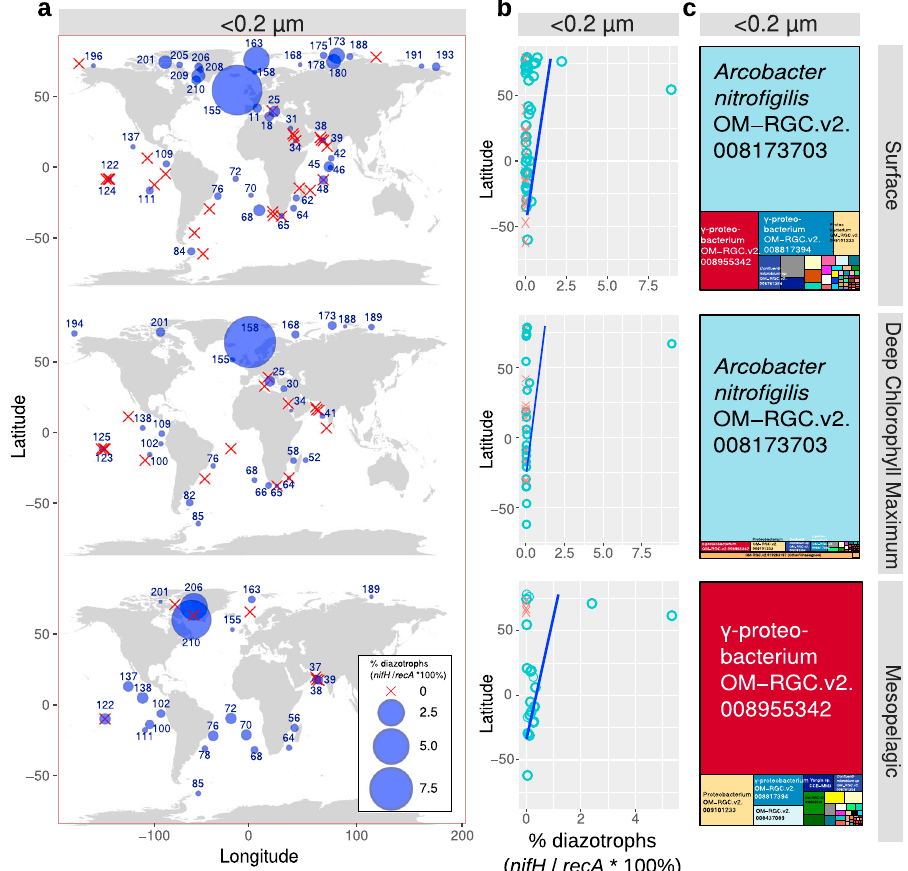
Fig. 10 Detection of ultrasmall diazotrophs in metagenomes obtained from <0.22 µ m size-fractionated samples of different water layers. The percentage of diazotrophs among ultrasmall bacterioplankton was estimated by the ratio of metagenomic read abundance between the marker genes nifH and recA . a Biogeography. The bubble size varies according to the percentage of diazotrophs, while red crosses indicate absence (i.e., no detection of nifH reads). Station labels with diazotrophs detection are indicated in blue. b Latitudinal abundance gradient. Circles correspond to samples with diazotrophs, while crosses indicate absence. The blue lines correspond to generalized additive model smoothings. c Taxonomic distribution of the nifH reads. The ‘ OM- RGC.v2 ’ pre fi x indicates the nifH sequences assembled from metagenomes of <3 μ m size fractions 22 , including <0.22 μ m. Source data are provided as a Source data fi